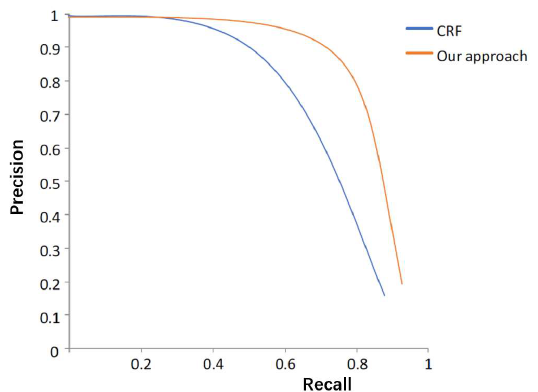
Figure 11. Precision-recall curve for detecting lemons using the CRF-based approach and the proposed approach.